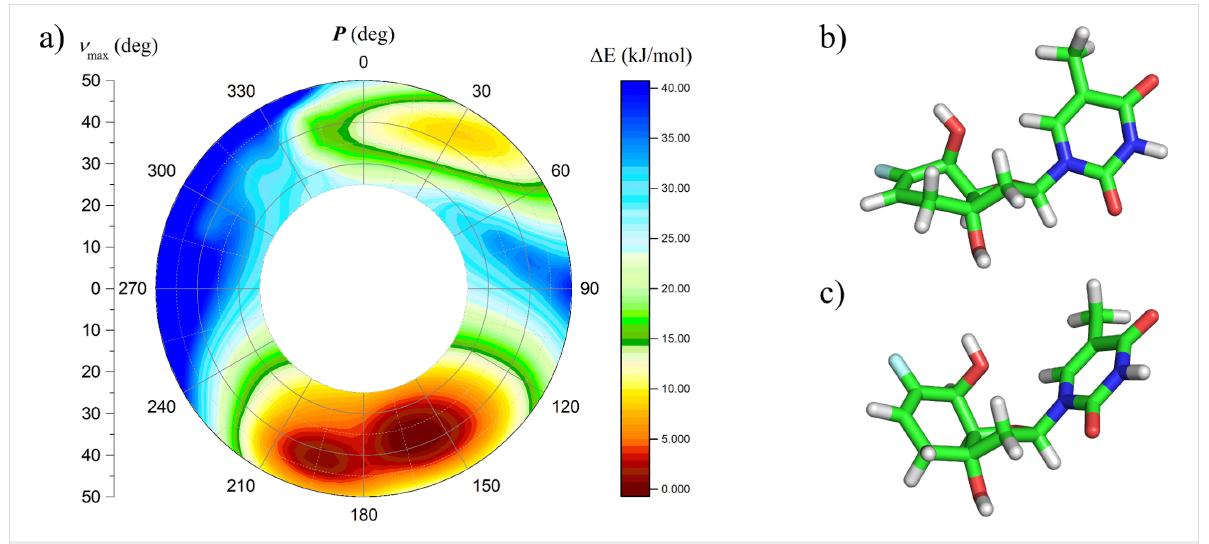
Figure 3: a) Potential energy profile versus pseudorotation phase angle of nucleoside 8 and its two minimal energy conformers: b) C2’- endo and c) C3’- exo .